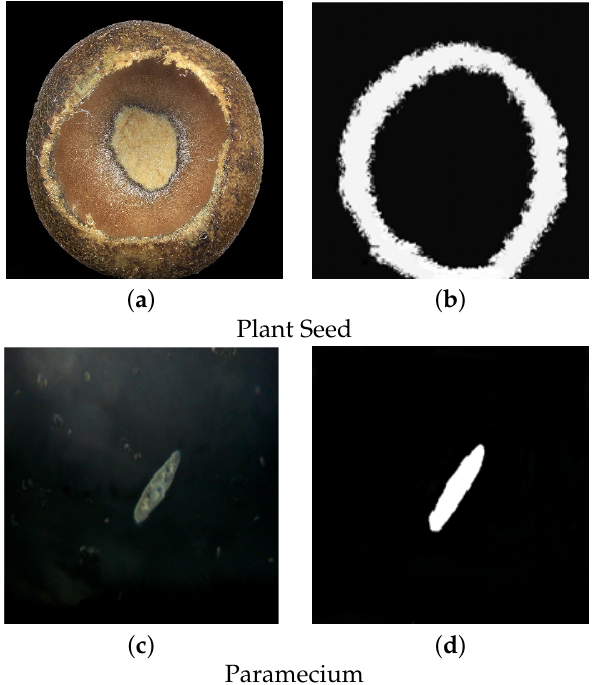
Figure 11. The proposed scheme is applied to microscopic images. ( a ) is about original input image of a Plant Seed while its segmentation map is illustrated in ( b ). ( c ) is the original input image of Paramecium and ( d ) is the segmented Paramecium